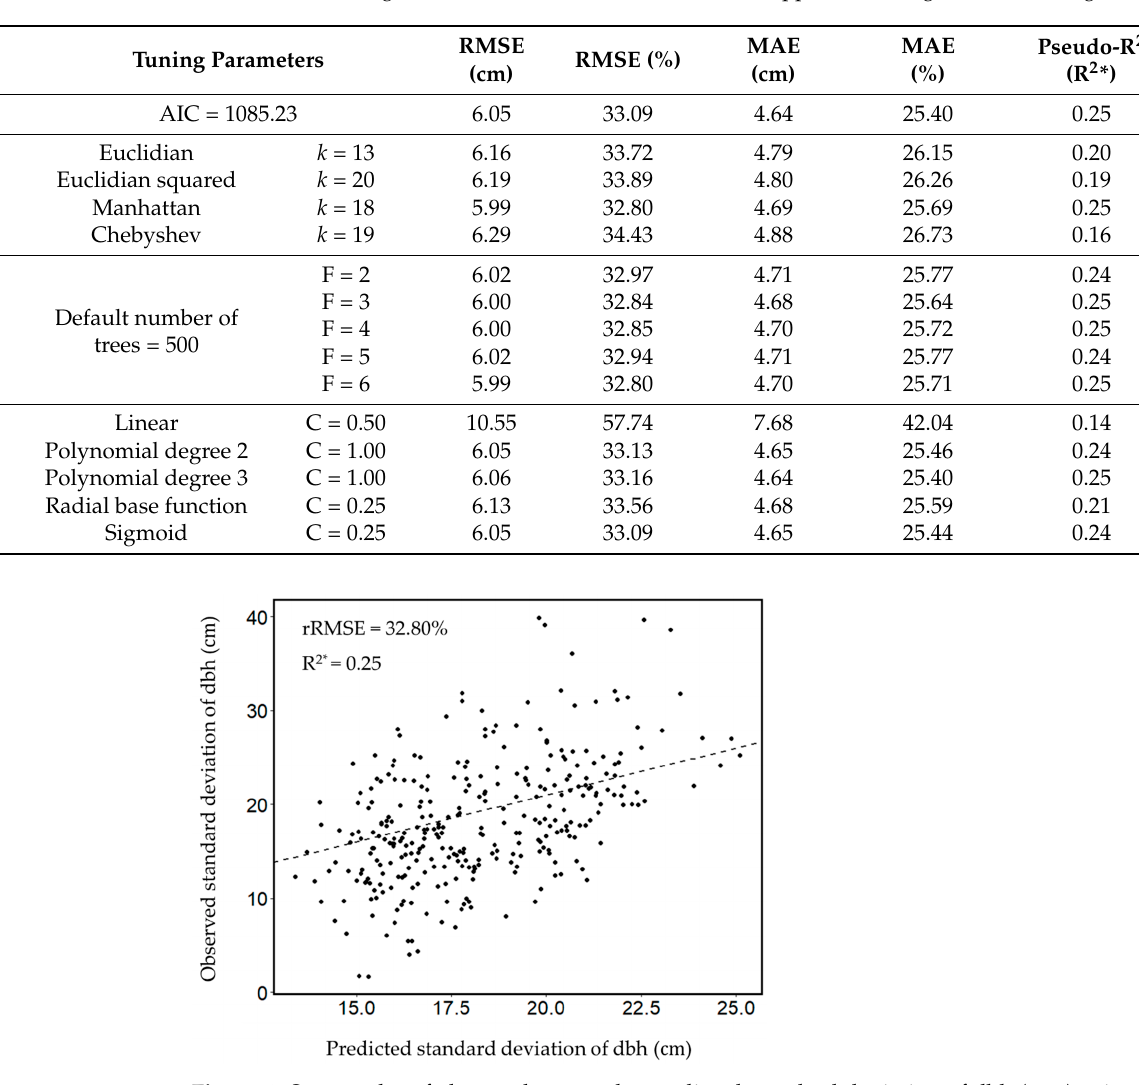
Figure 4. Scatter plot of observed versus the predicted standard deviation of dbh ( σ dbh ) using the k -NN algorithm. The dashed line represents a 1:1 relationship.